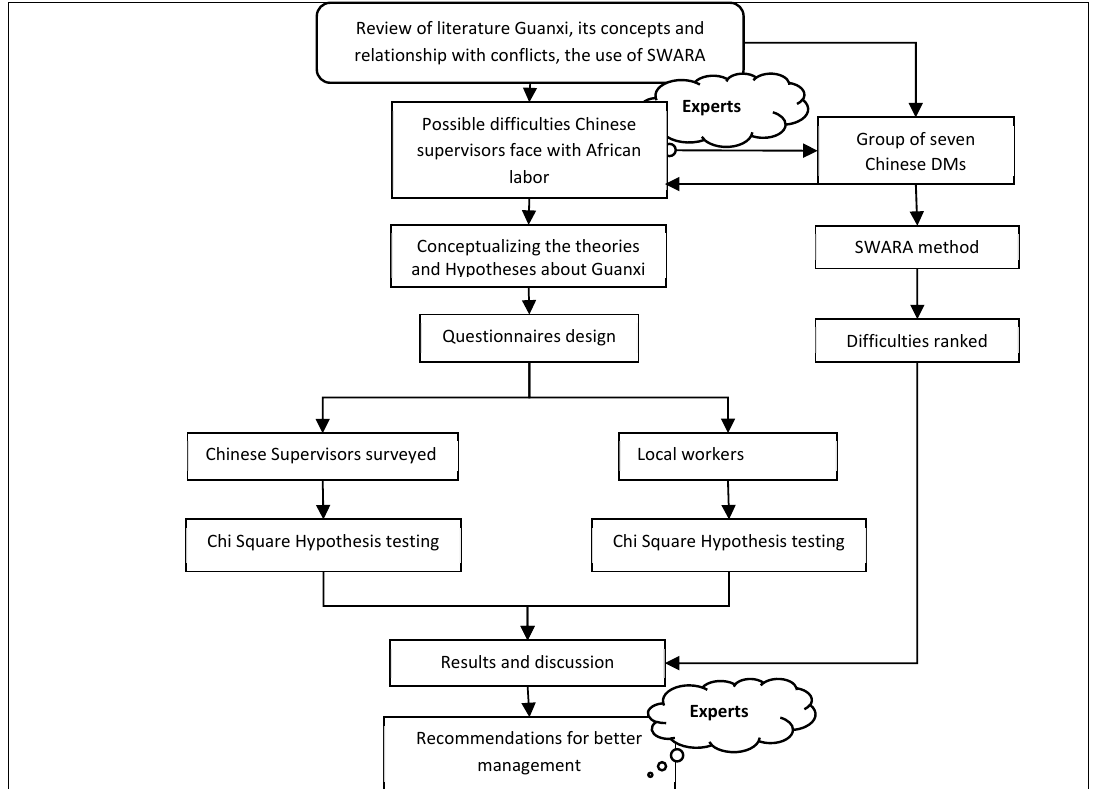
Fig.1: Adopted research framework